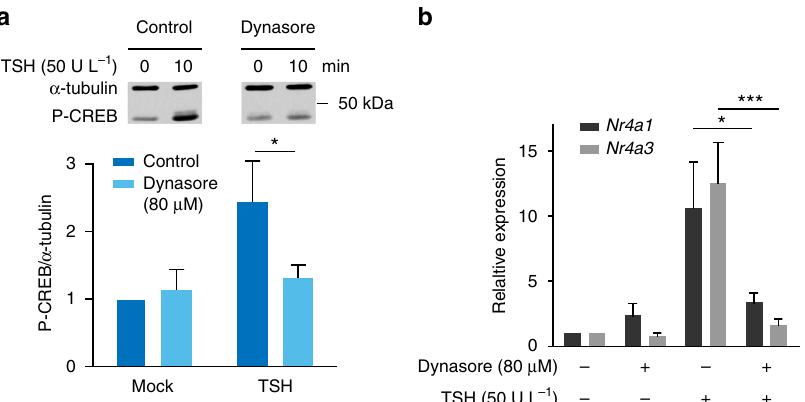
Fig. 6 TSHR internalization is required for TSH-dependent induction of CREB phosphorylation and gene transcription. a Western blot analysis of CREB phosphorylation (Ser133) in primary mouse thyroid cells stimulated with TSH with/without dynasore pretreatment (30 min). α -tubulin was used as loading control. b Induction of early genes in response to TSH in primary thyroid cells with/without dynasore pretreatment (30 min). Data in a and b (mean ± s.e. m.; n = 5 each) are expressed relative to those measured in mock-stimulated control. Differences in a and b are statistically signi fi cant by two-way ANOVA. * P < 0.05 and *** P < 0.001 by Bonferroni ’ s post